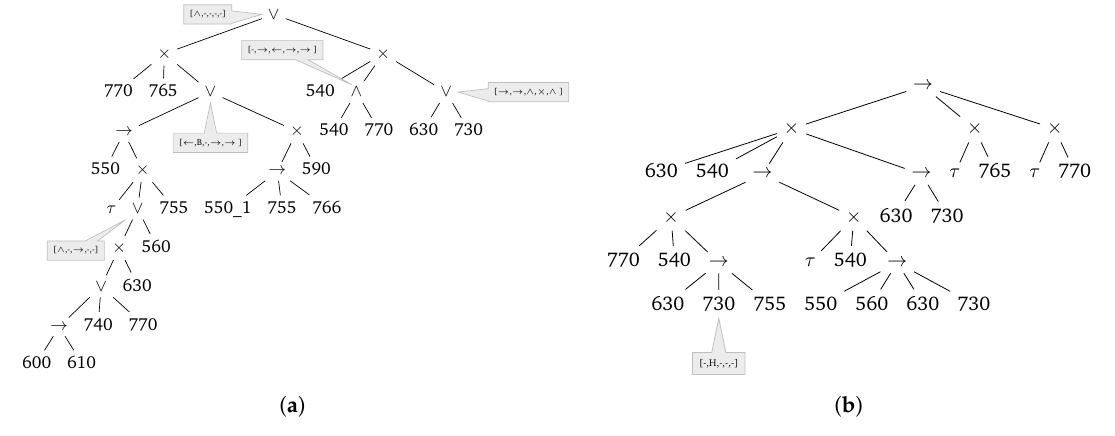
Figure 13. Process trees originally discovered by the evolutionary tree miner (ETM) on the building permits process event logs. ( a ) ETM Approach 3; ( b ) ETM Approach 4.